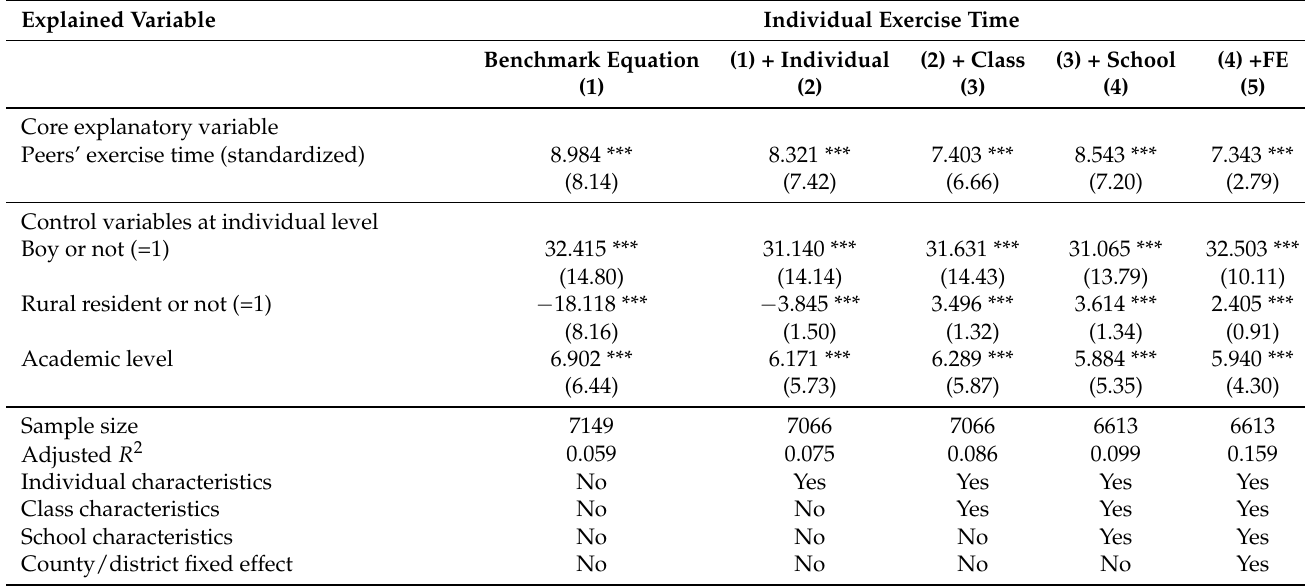
Table 2. Benchmark Model Regression